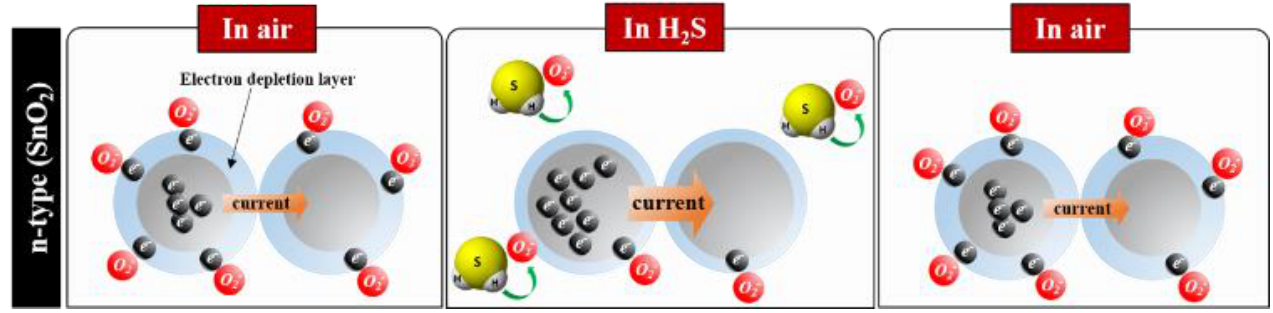
Figure 1. The oxygen-related gas-sensing mechanism involves the absorption of oxygen molecules on the SnO 2 surface to generate chemisorbed oxygen species (O 2 − , O − and O 2 − ) by capturing electrons from the conductance band, which makes the SnO 2 surface highly resistive.